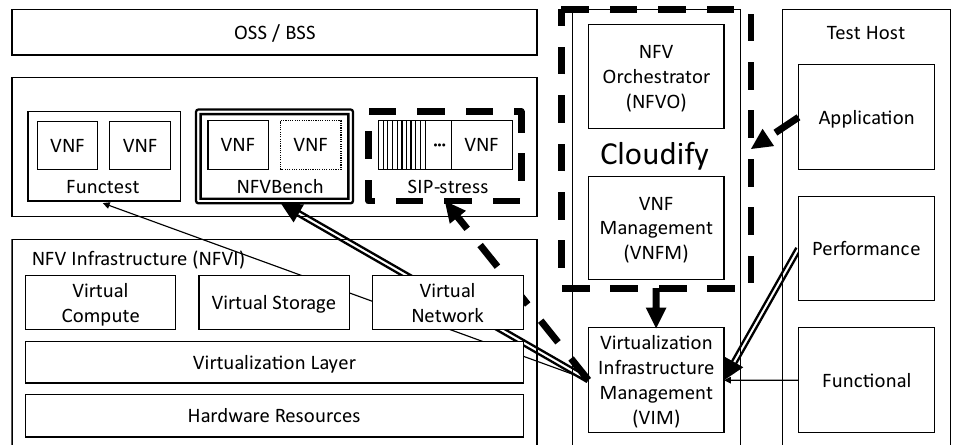
Figure 5. Proposed testing framework for comprehensive verifications on the NFV cloud.